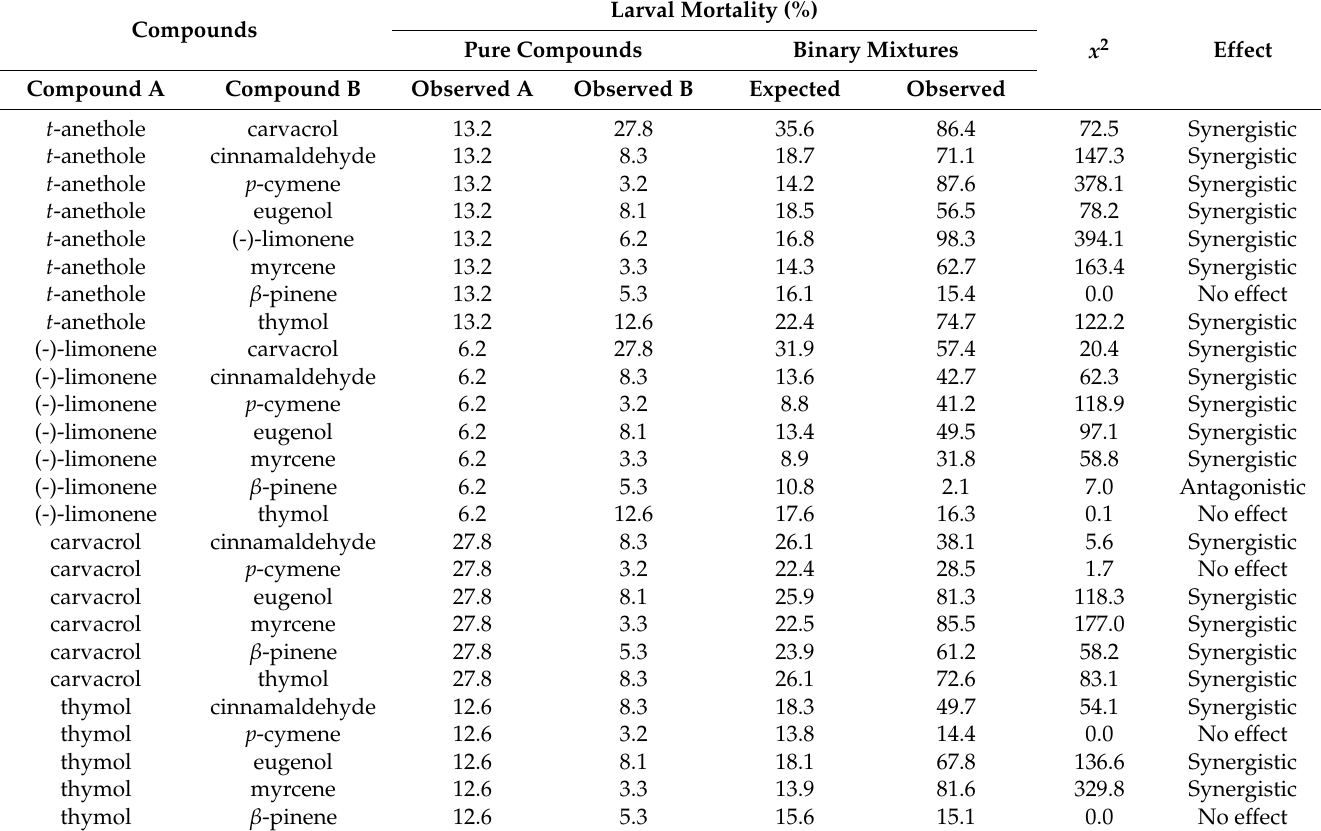
Larval Mortality (%)